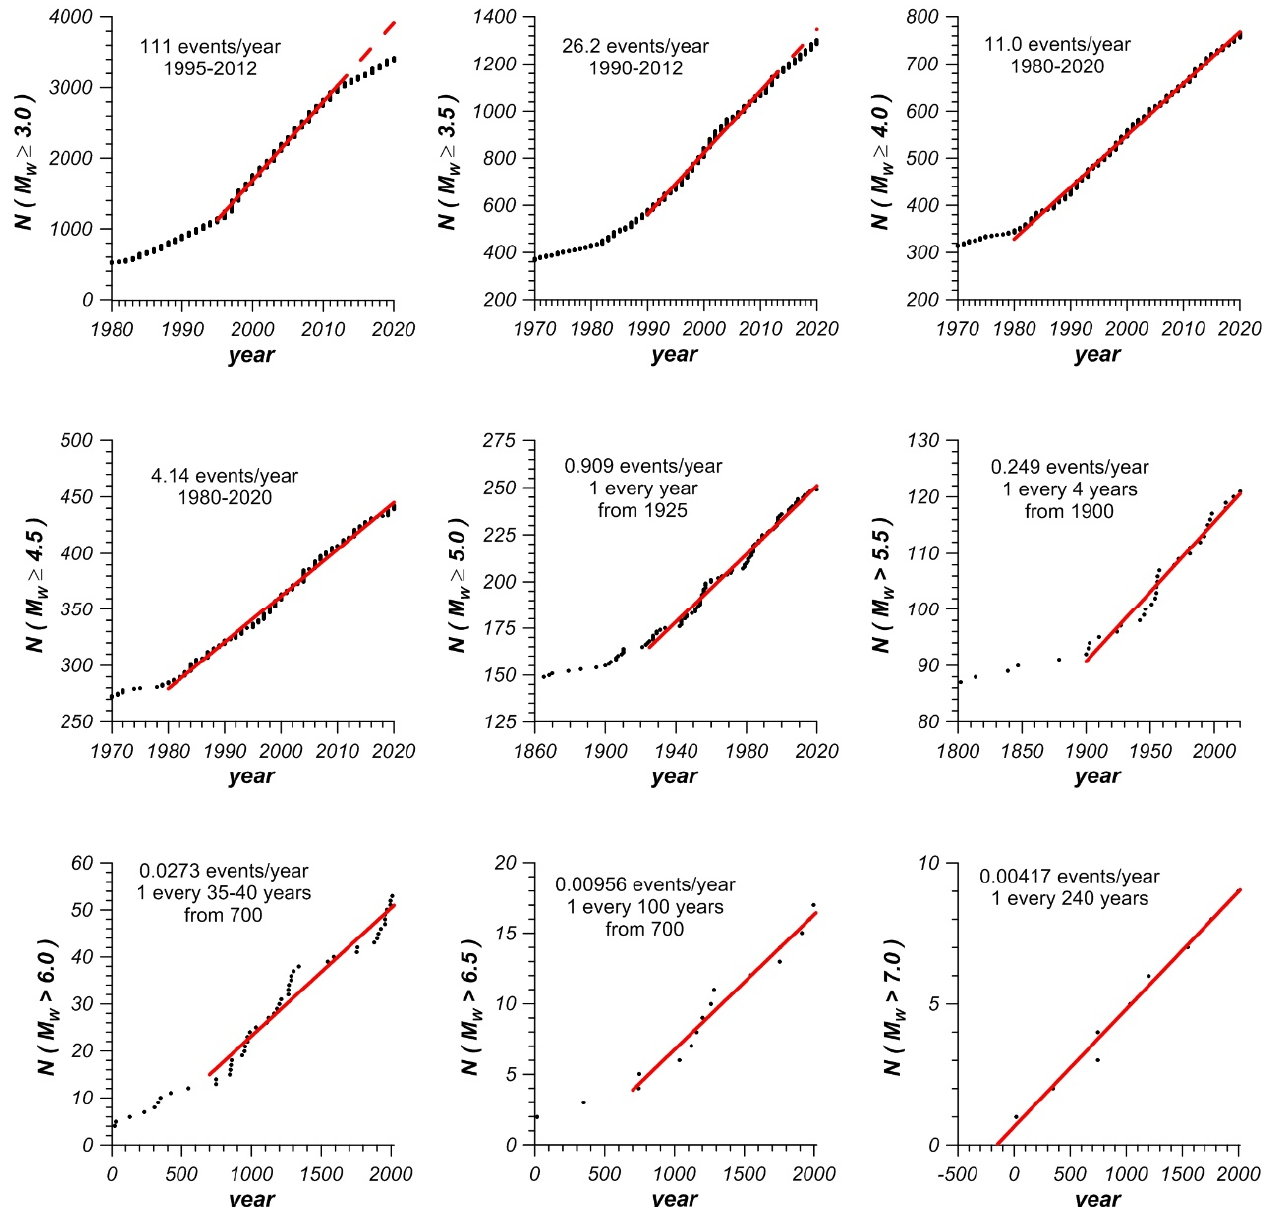
Figure 2. Completeness analysis for the updated and declustered catalog. Completeness rates are also depicted. A recent database of focal mechanism solutions (1951–2019) has been provided in Rashwan et al. [61]. These focal mechanism solutions (Figure 5) have been used to study the seismotectonics pattern of the investigated region as well as to define and delimitate the studied seismic sources. Differentiation of the different faulting mechanisms based on their rake angle was considered (Figure 5), i.e., pure normal-faulting (NF),